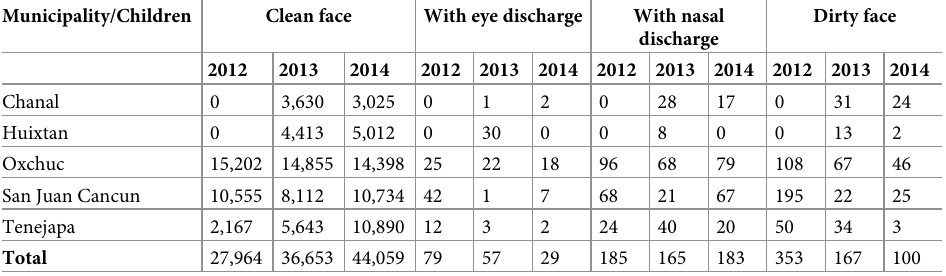
Table 5. Assessment of facial hygiene in municipalities known to have trachoma in Chiapas. 2012–2014. Source: State Program for the Prevention and Control of Trachoma.